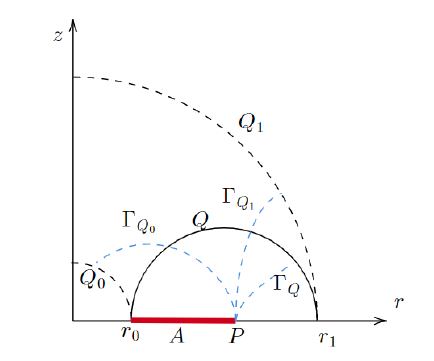
Figure 18 . The branes Q 0 and Q 1 are the solution without perturbation and exact hemisphere. the blue dashed lines represent geodesic connecting a point P and